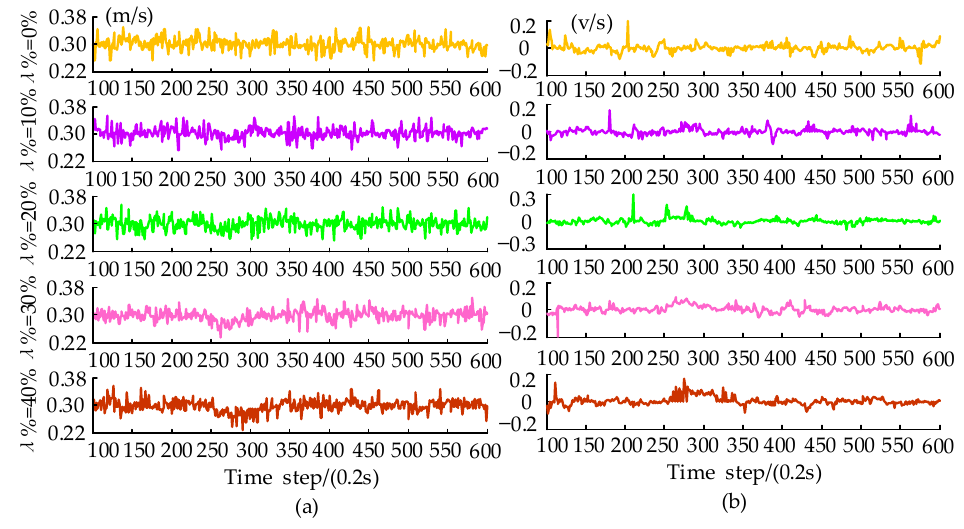
Figure 10. The selected experimental data: ( a ) The surge speed of AUV; ( b ) The change rate of the control voltage for main thrusters.